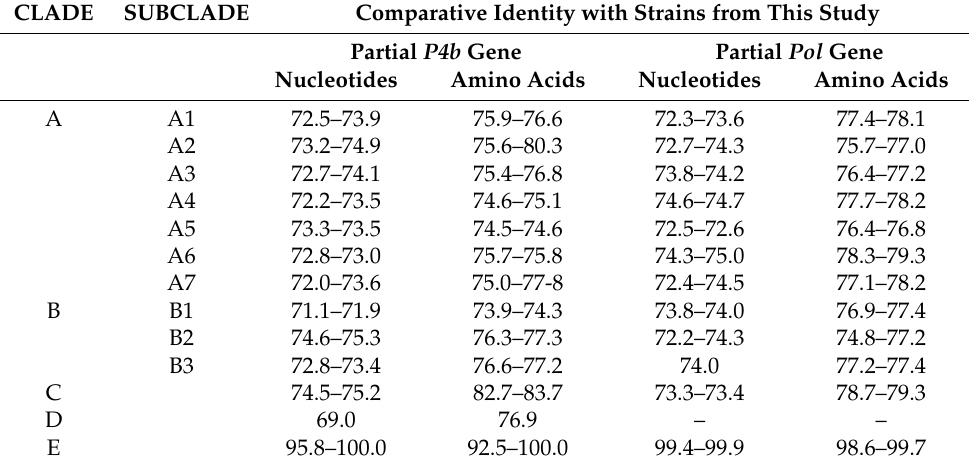
Table 2. Nucleotide and amino acid identity of studied strains compared with other APVs.